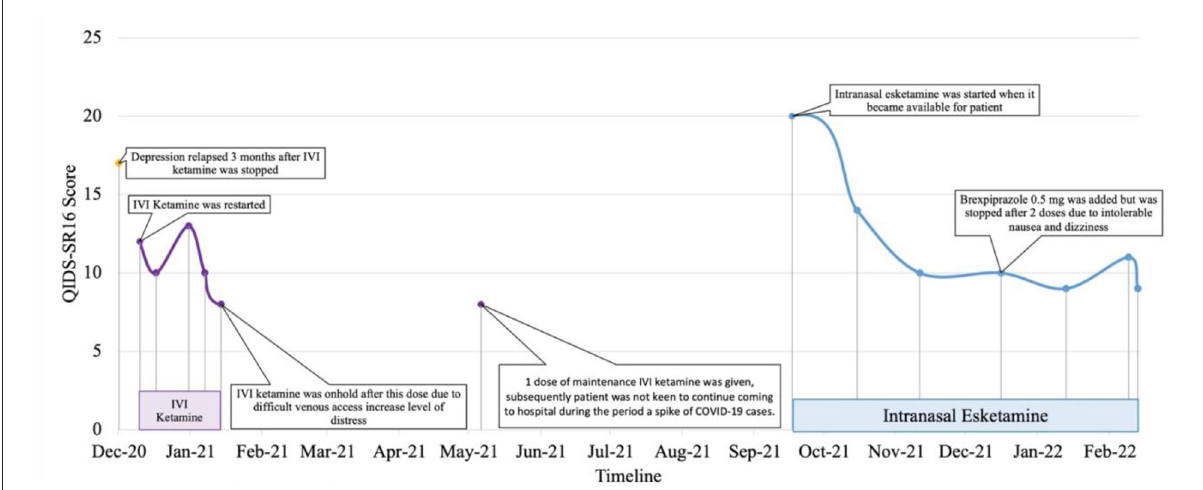
FIGURE5 Case 5 timeline for longitudinal course of treatment response. Patient 5 is a Chinese female in her late 50’s with a current diagnosis of treatment-resistant unipolar depression with physical co-morbidity of sacral fracture. She was on IVI ketamine since 2012 with symptomatic remission as reported in another published case series. IVI ketamine was witheld on July 2020 in view of patient’s concern of contacting with COVID-19 cases during hospital visit. Her depression relapsed on Dec 2020 where IVI ketamine was restarted and subsequently reduction of QIDS-SR16 score. Co-medications include esketamine 56mg fortnightly, agomelatine 50mg, quetiapine 800mg, mirtazapine 45mg, lorazepam 1mg BD, zolpidem 10mg, and clonazepam 2mg PRN. Her depressive symptoms and functioning improved after 3 months on